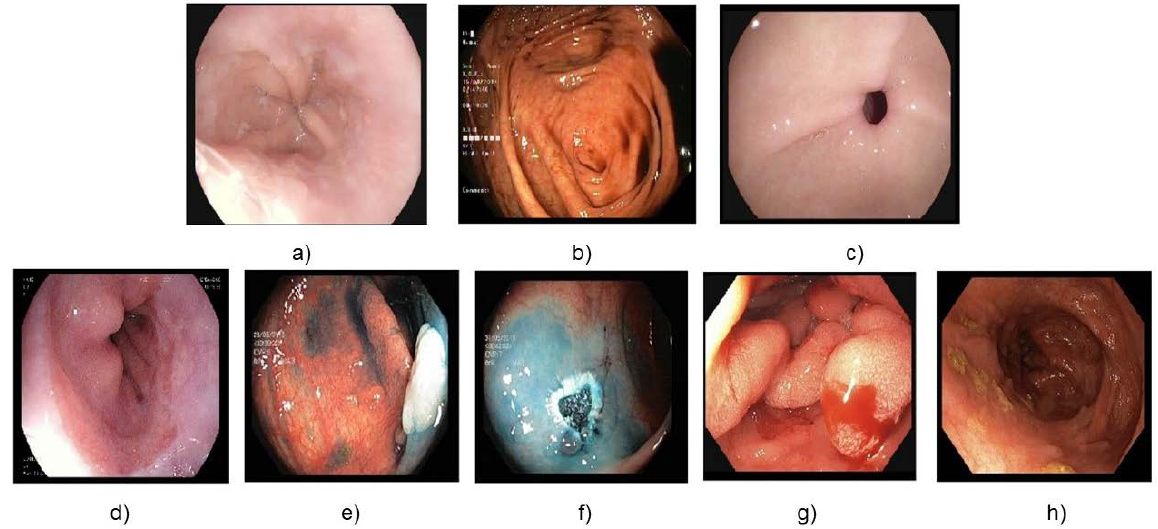
Figure 2. Dataset classes: ( a )normal z-line, ( b ) normal cecum, ( c ) normal polorus, ( d ) esophagitis, ( e ) dyed and lifted polyps, ( f ) dyed dissection margins, ( g ) polyps, and ( h ) ulcerative colitis.